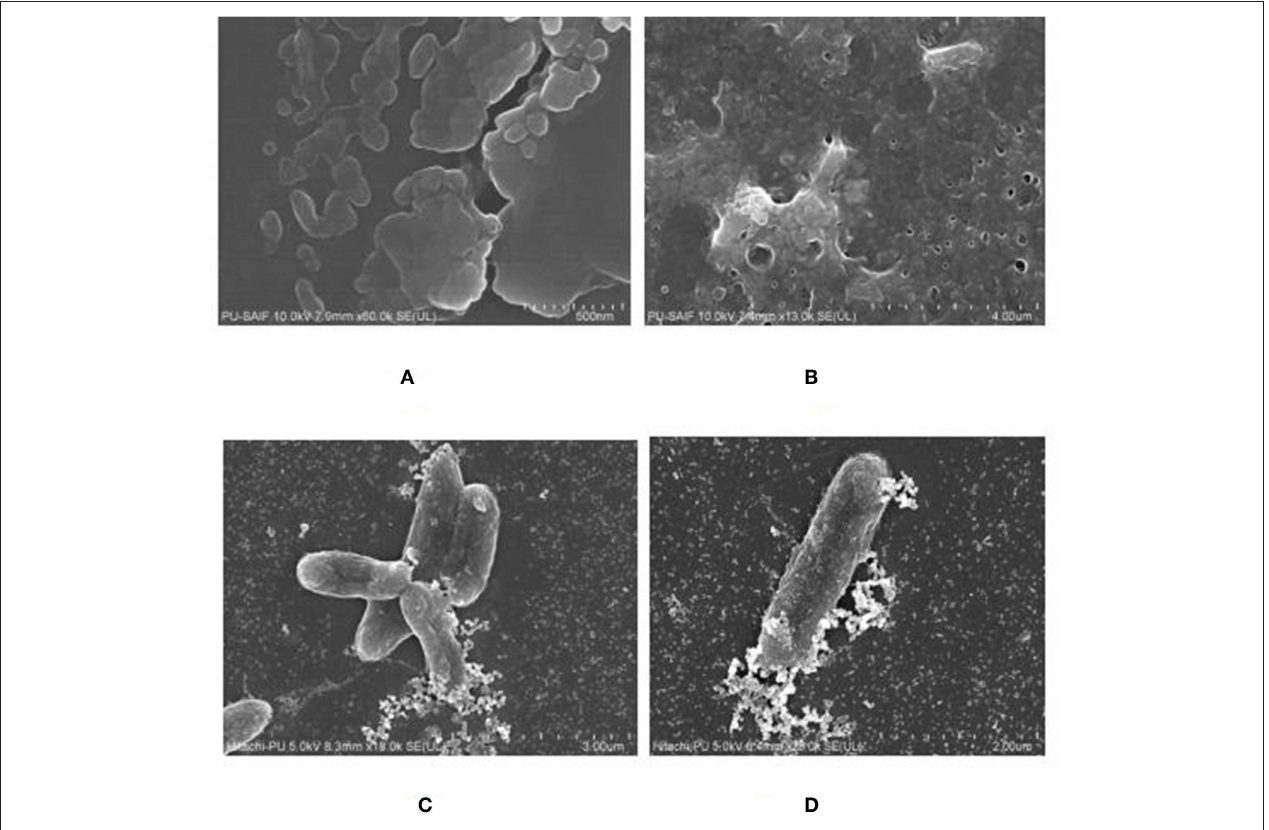
FIGURE 8 | FeSEM images of 24h. biofilm of K. pneumoanie B5O55 showing (A) characteristic cocobacilli shape of bacterial cells and (B) profuse secretion of extracellular matrix (ECM) by the bacteria during biofilm formation. Water channels are clearly visible as pores in ECM. (C) and (D) The interaction between nanoparticles and bacterial cells could be seen with a visible decrease in the presence of polysachharide inside biofilm milieu.